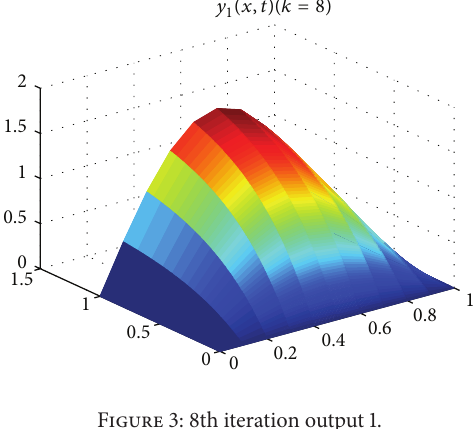
Figure 6: Error surface 2 (iteration 8).